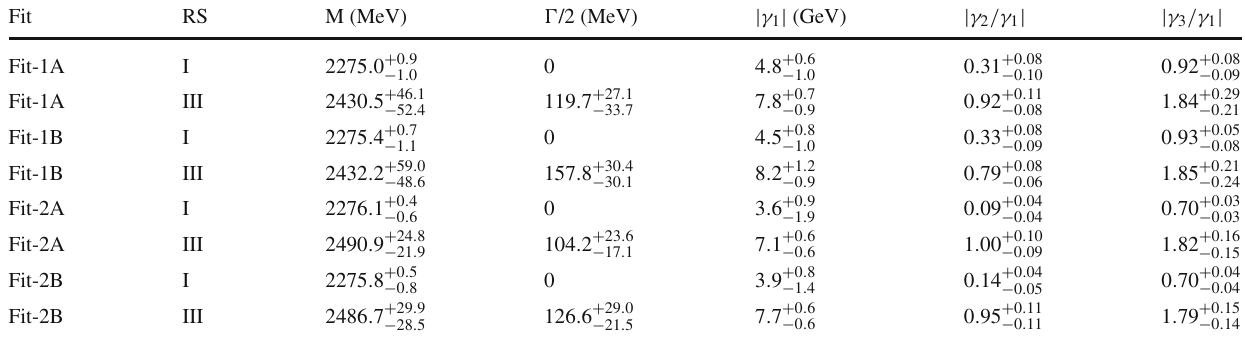
Table 3 Poles and their residues obtained at unphysical meson masses nels D π, D η and D s ¯ K in order. The thresholds of the D π, D η and D s ¯ K channels are 2276 . 5 , 2472 . 4 and 2500 . 5 MeV, respectively. ( m π = 391 MeV) used in the lattice simulation [28] from the S - wave coupled D π, D η and D s ¯ K scattering amplitudes with ( S , I ) = ( 0 , 1 / 2 ) . The indices of the residues γ i = 1 , 2 , 3 correspond to the chan-